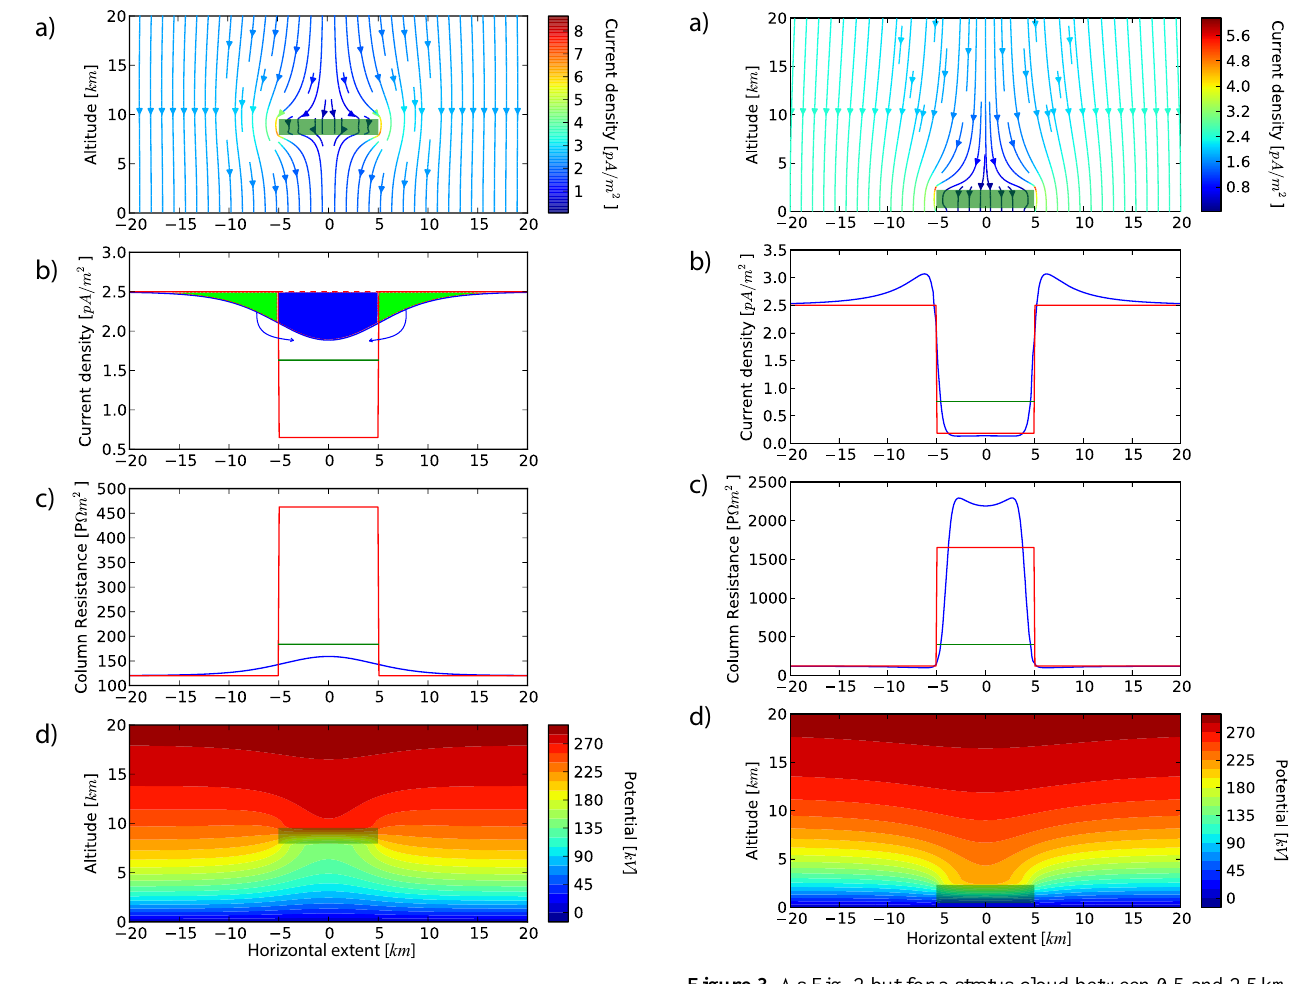
Figure 2. Current streamlines and total current density around a cir- rus cloud (indicated by the green box) with a diameter of 10km, lo- cated between 8 and 9.5km altitude (a) . Model air-to-earth current density (blue), restricted to vertical currents only (red), and mean effective cloud current density (green) (b) . Effective column resis- tance b R col (blue), column resistance for considering vertical cur- rents only R col (red), and mean effective cloud column resistance b R cloud col (green) (c) . Potential difference distribution (d) .